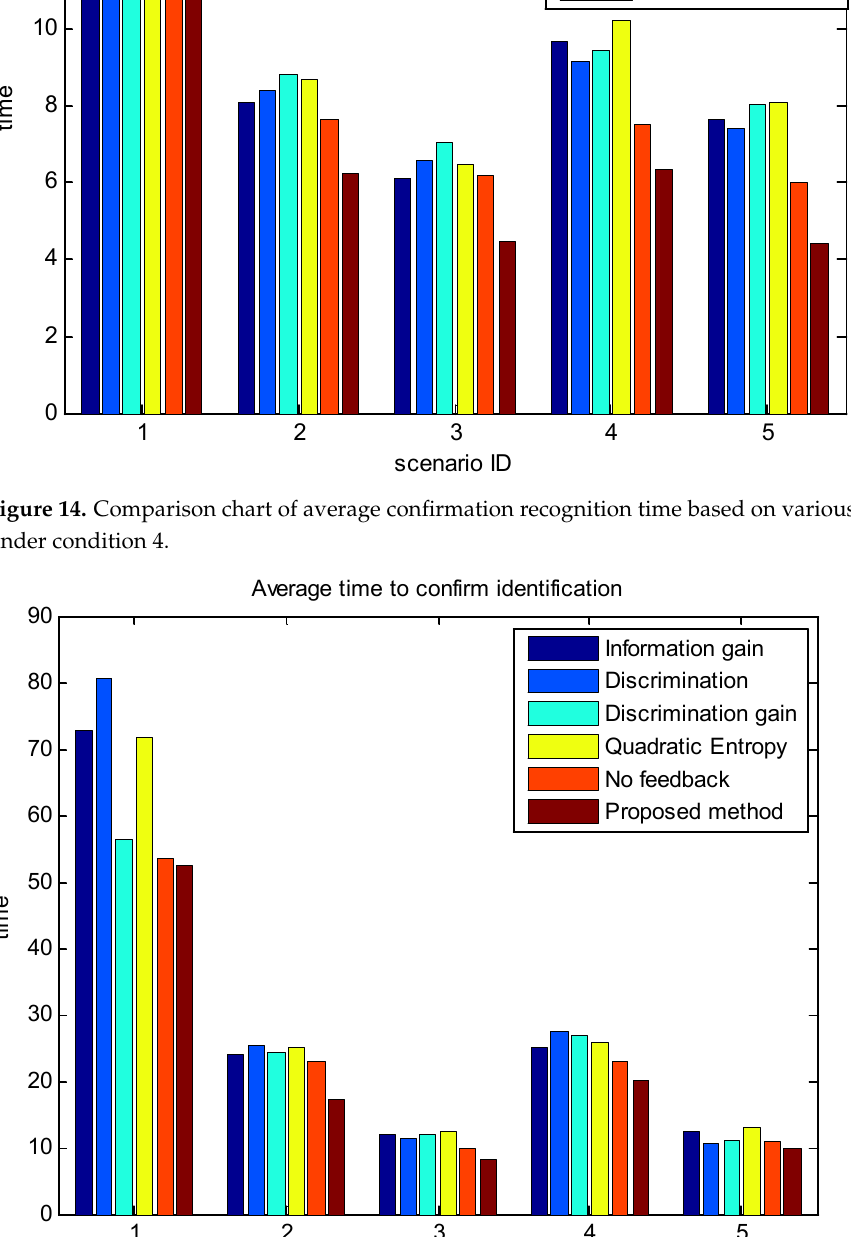
Figure 15. Comparison chart of average confirmation recognition time based on various algorithms under condition 5.